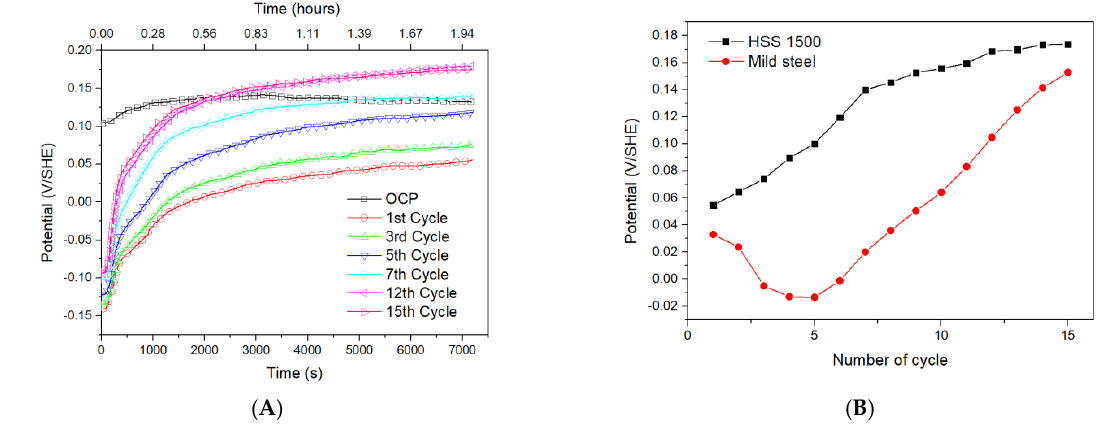
Figure 3. ( A ) Monitoring of the rest potential of HSS 1500 using Hg/HgO saturated reference elec- trode in 0.1 M NaOH aqueous electrolyte, after cathodic treatment with a current density − 5 mA/cm 2 for 2.22 h. ( B ) the rest potential measured at 2 h for HSS 1500 and mild steel vs. the number of cathodic treatment cycle.